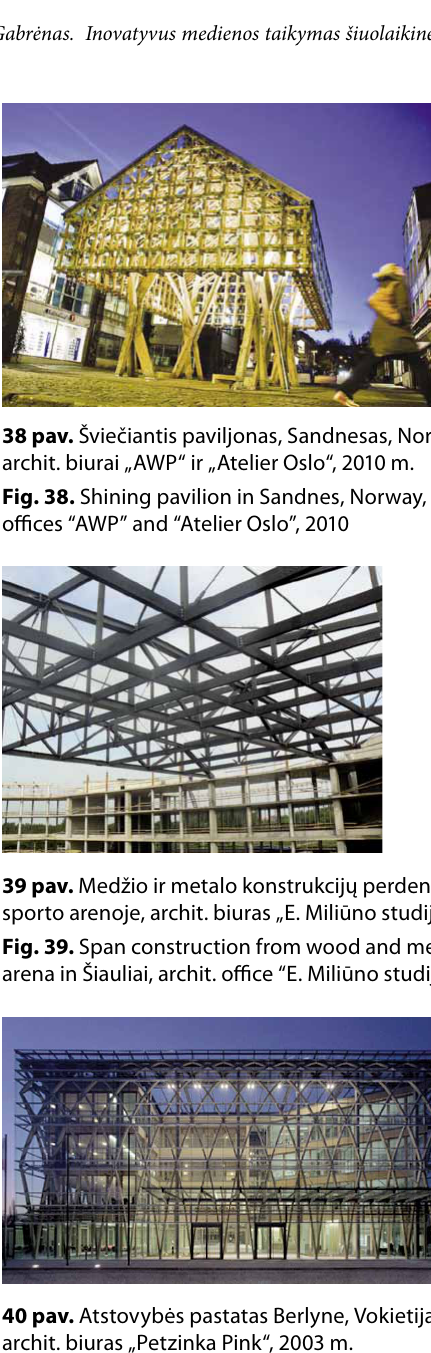
40 pav. Atstovybės pastatas Berlyne, Vokietija, archit. biuras „Petzinka Pink“, 2003 m. Fig. 40. State Mission building in Berlin, Germany, archit. office “Petzinka Pink”,